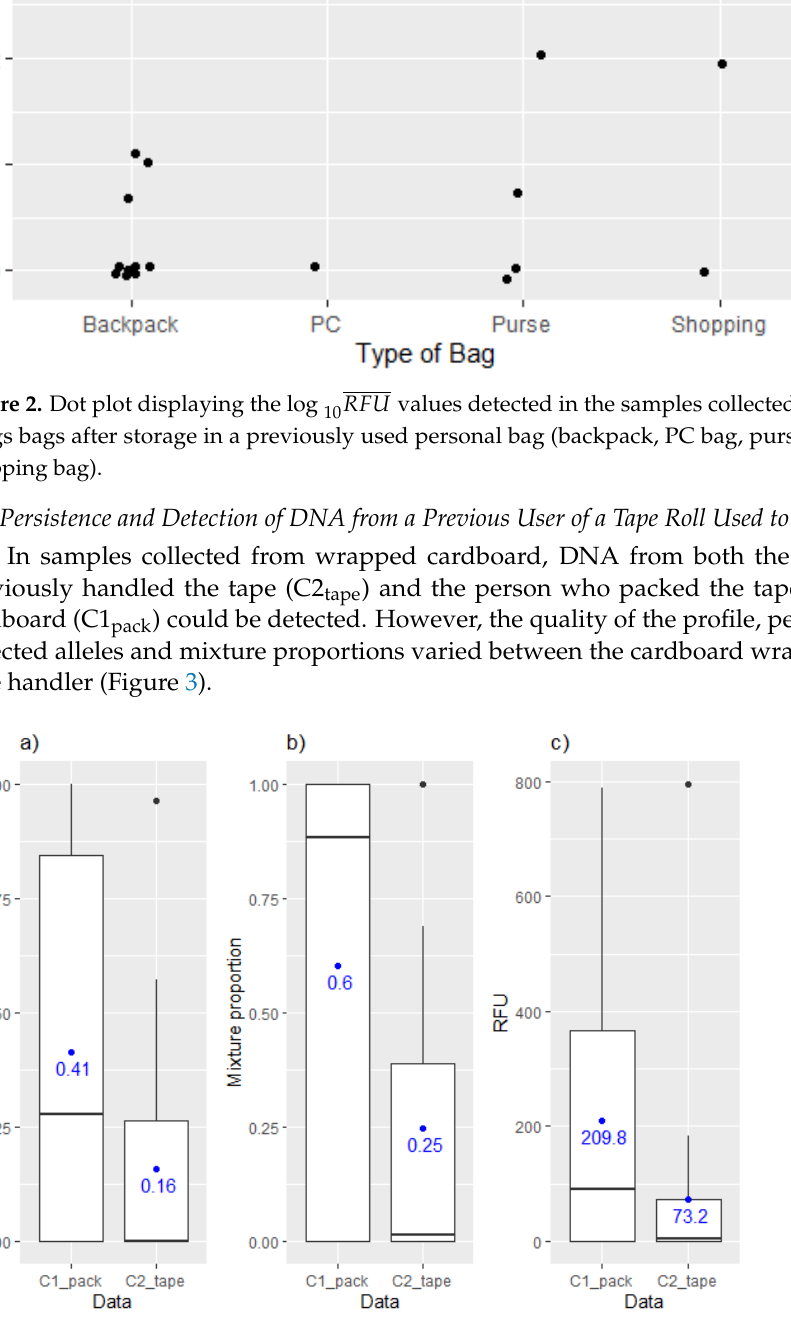
Figure 3. Boxplot displaying ( a ) proportion of unique alleles, ( b ) the mixture proportion and ( c ) RFU values corresponding to the wrapper (C1 pack ) and the handler (C2 tape ) of the tape.